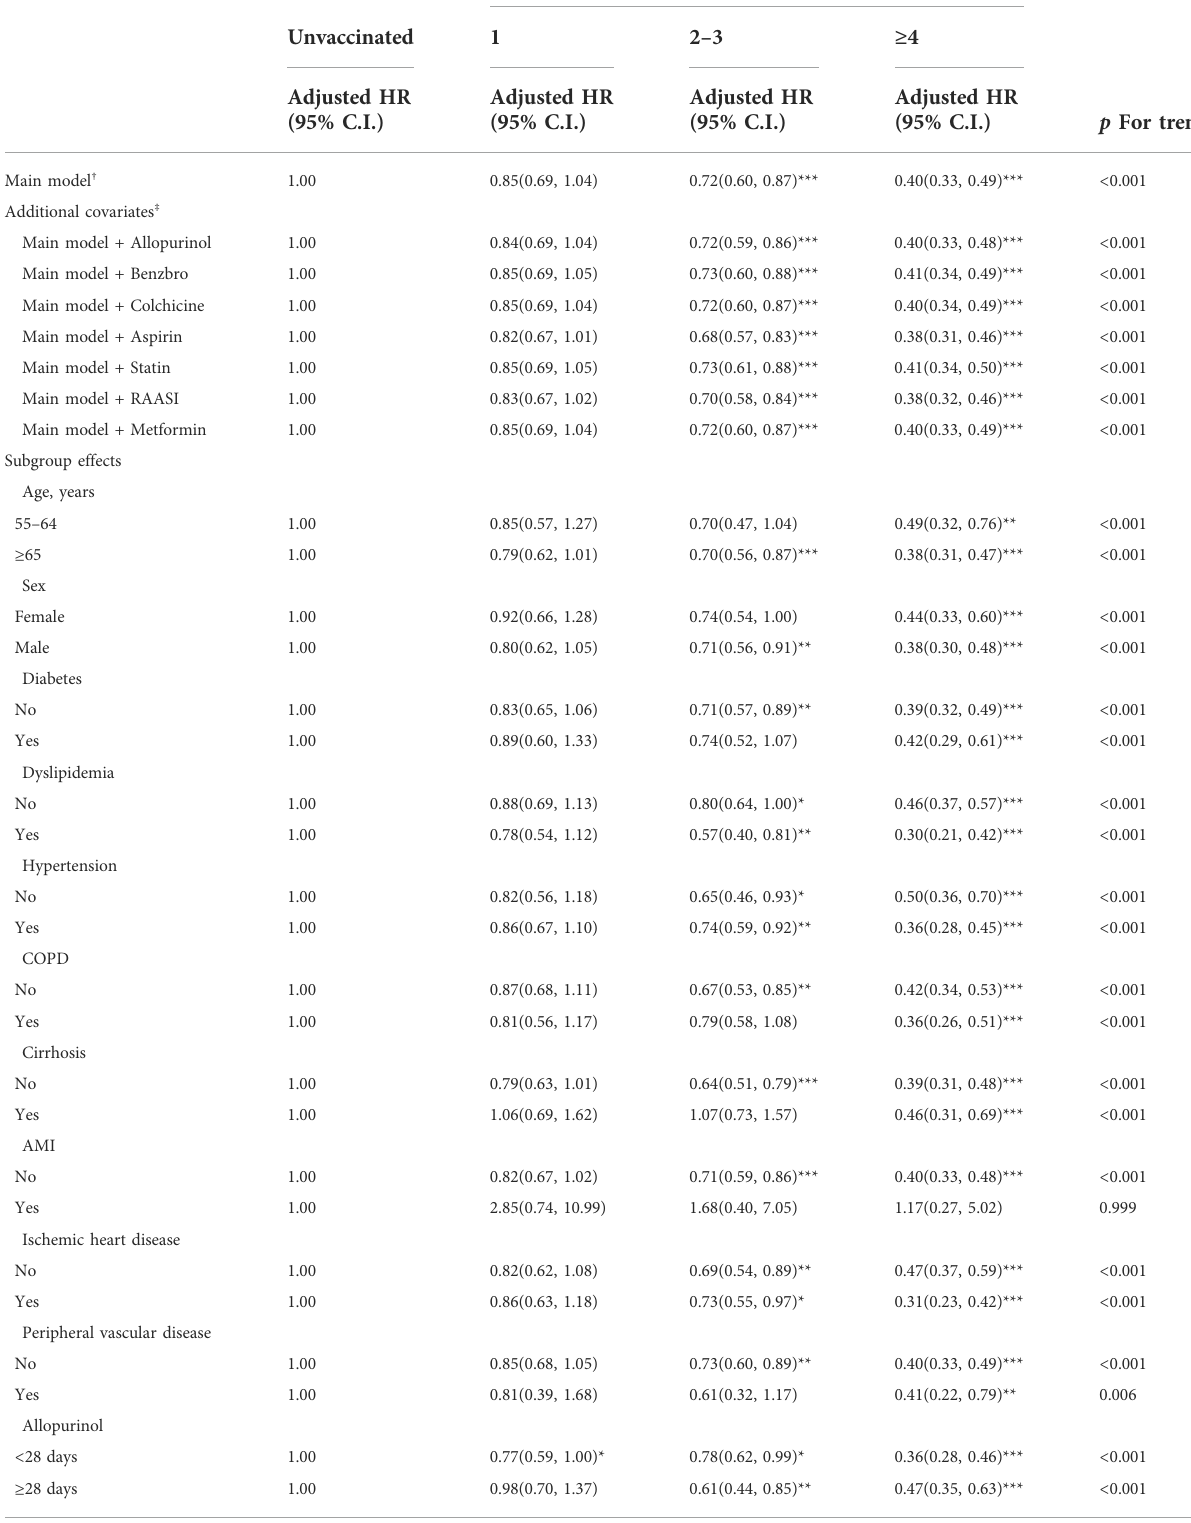
TABLE 3 Sensitivity analysis of adjusted HRs of vaccination in risk reduction of atrial fi brillation in in fl uenza